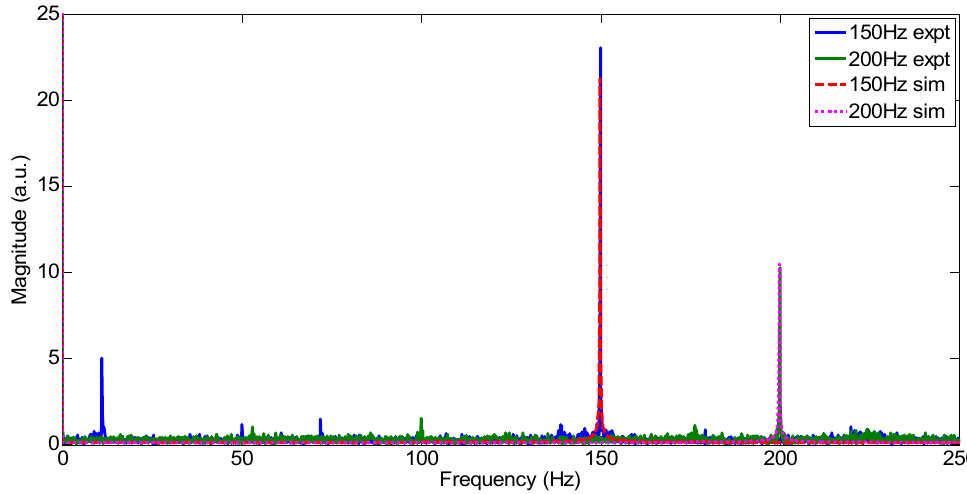
Figure 13. FFT data of experimental measurements at 150 Hz and 200 Hz, with sensing beam mounted on plate as shown in Figure 4. The simulated data are FFT results of the sinusoidal waves at 150 Hz and 200 Hz obtained from the analytical solution. F 0 is normalized to 0.2 N in both simulations for the best fit of the amplitude.